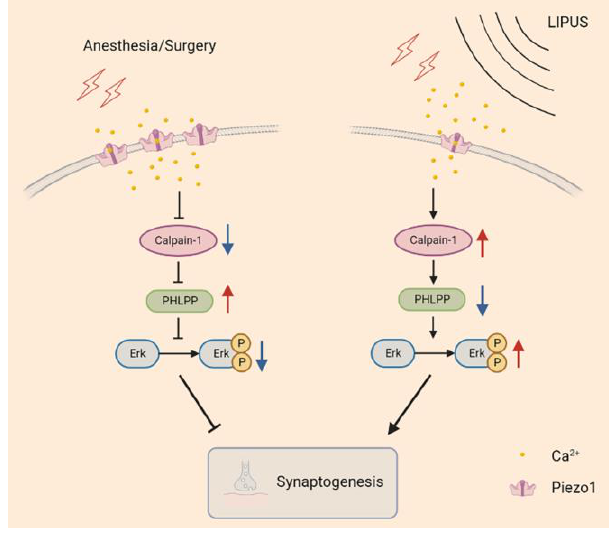
Figure 7. The possible signaling pathway of LIPUS mediated neuroprotection after anesthesia/surgery in aged mice. Piezo1 expression was increased in aged mice undergoing anesthetic surgery, and an excessive influx of Ca 2+ inhibited calpain1 activity, manifested as reduced PHLPP degradation, further alleviated Erk phosphorylation, and led to synapse dysfunction (left column). In contrast, LIPUS application inhibited Piezo1 expression and enhanced calpain1 activity, promoting PHLPP degradation, which released the inhibition of Erk phosphorylation and rescued synaptic function (right column).